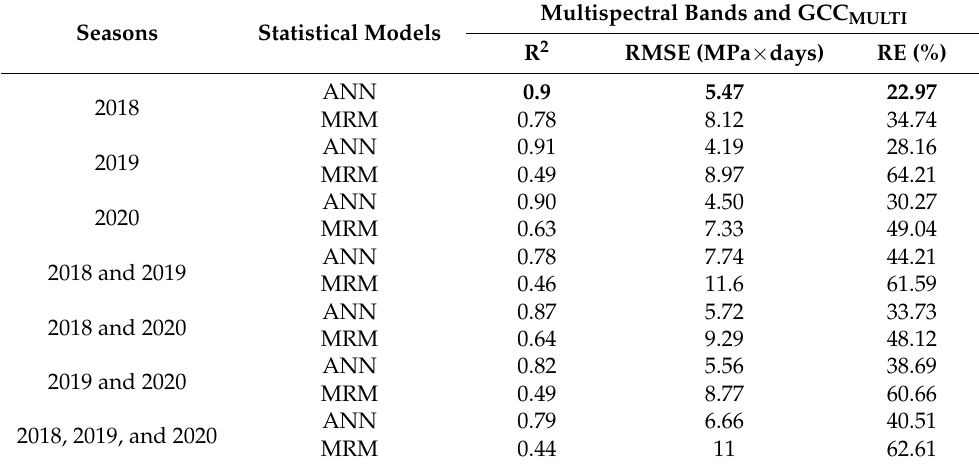
Table 5. Validation results (R 2 : determination coefficient, RMSE: root mean squared error, and RE: relative error) for the ANN regression models and MRM using multispectral bands and GCC MULTI to simulate the S ψ for every studied season in a vineyard cv. Monastrell, located in south-eastern Spain. Statistical values shown in bold indicate the best-performing model.